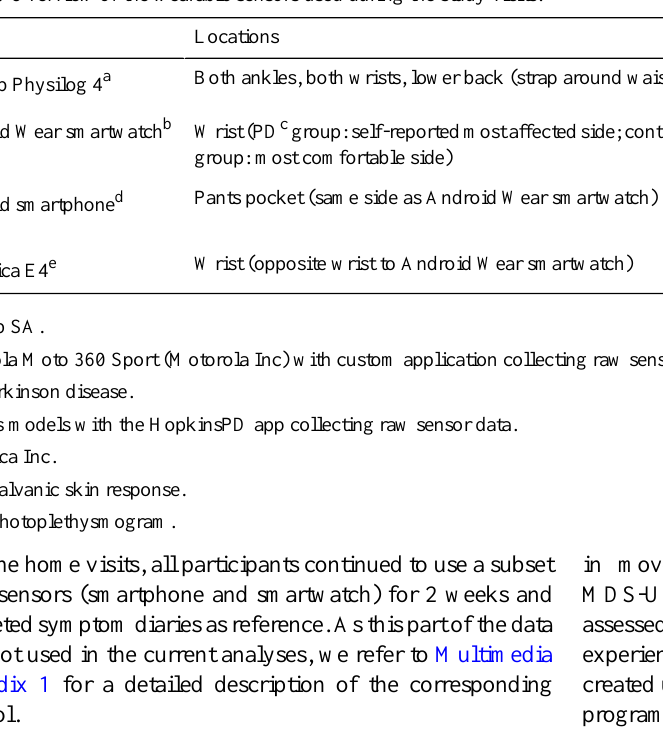
Table 1. Overview of the wearable sensors used during the study visits.